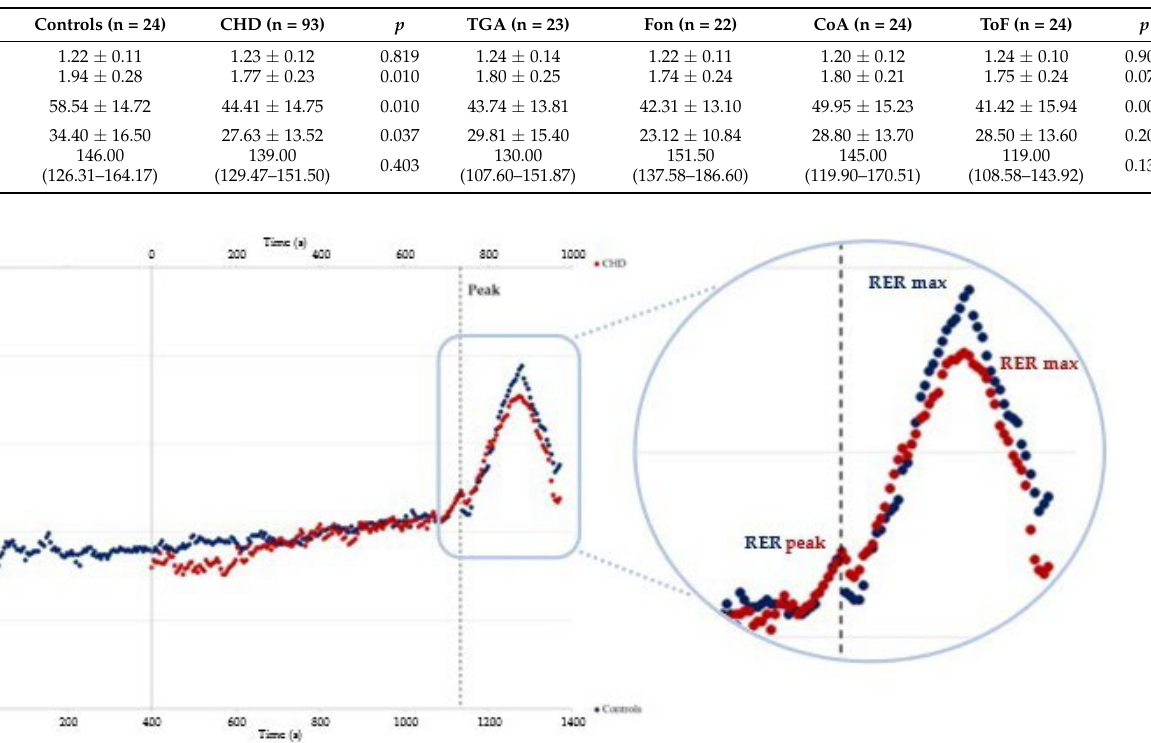
Table 4. Correlations between the respiratory exchange ratio (RER) recovery parameters and cardi- opulmonary/echocardiographic functional indices, expressed as Pearson’s or Spearman’s indices. Variables